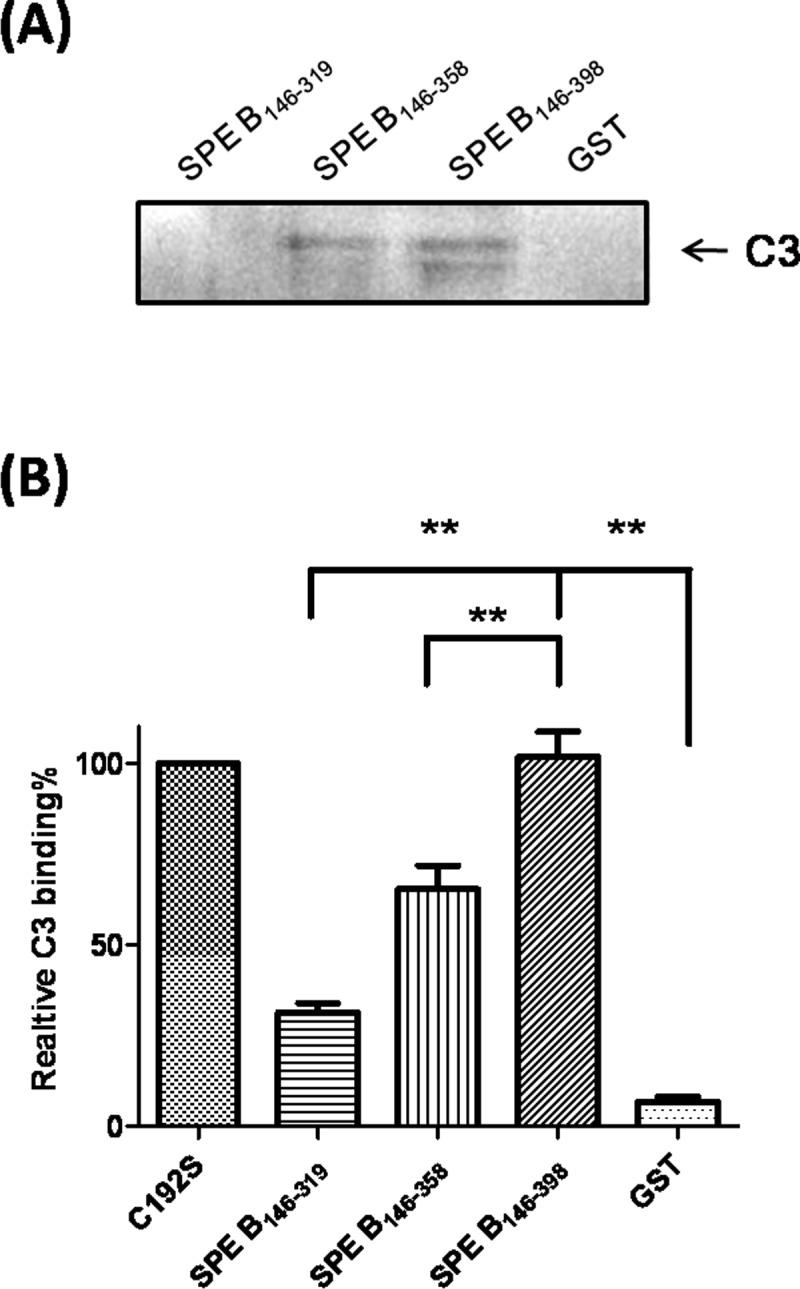
Binding of the SPE B fragments to human serum C3.(A) Immunoblot for complement C3 using eluents from GST-sepharose beads or different SPE B fragments conjugated the GST-sepharose beads and incubated with human serum. The reaction eluents were separated using 12% SDS-PAGE and blotted with goat anti-human C3 polyclonal antibody, as described in the Materials and Methods. (B) ELISA for binding of serum C3 to coated C192S, GST or SPE B fragments. The binding efficiencies were expressed as the ratios of C3-binding to the SPE B fragments to the binding of C3 to C192S, as described in the Materials and Methods. **P< 0.01, compared with values determined for SPE B146–398.